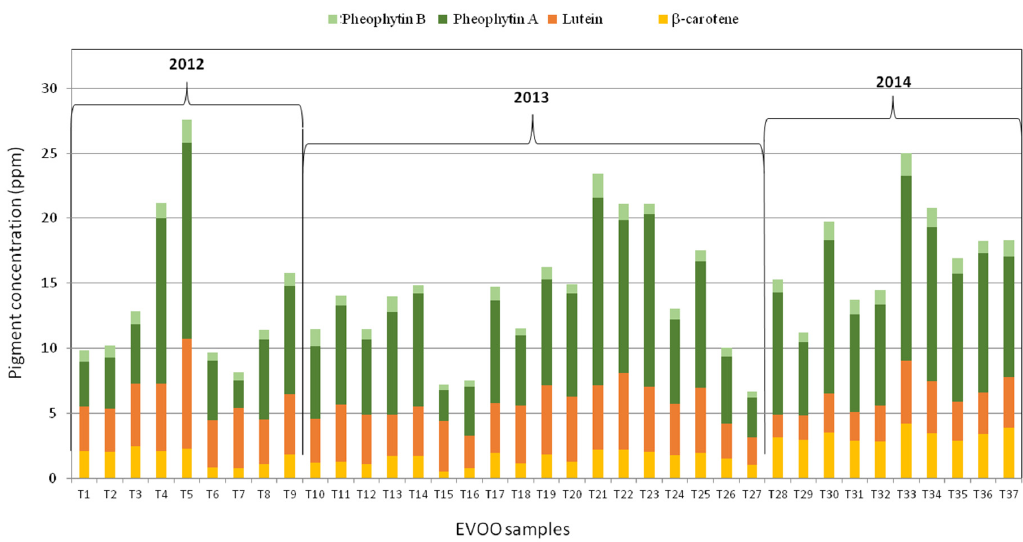
Figure 3. Profile of the four main pigments ( β -carotene, lutein, pheophytin A, and pheophytin B) determined by the mathematical analysis of the near UV-vis absorption spectra of the EVOO samples investigated in this work. Samples are labelled from T1 to T37, as shown in Table 1. Three groups of samples can be visualized depending on the year of olive harvesting (2012, 2013, and 2014).